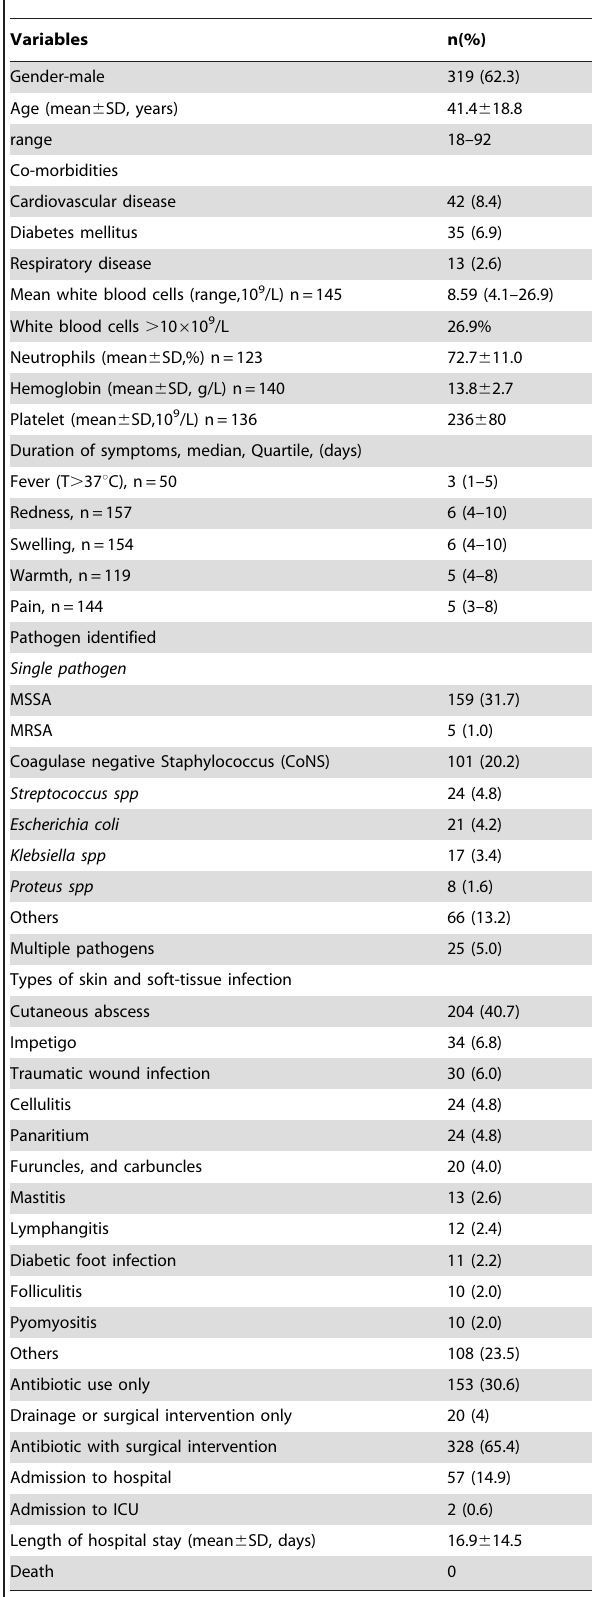
Table 1. Demographic and clinical features of patients with skin and soft-tissue infections